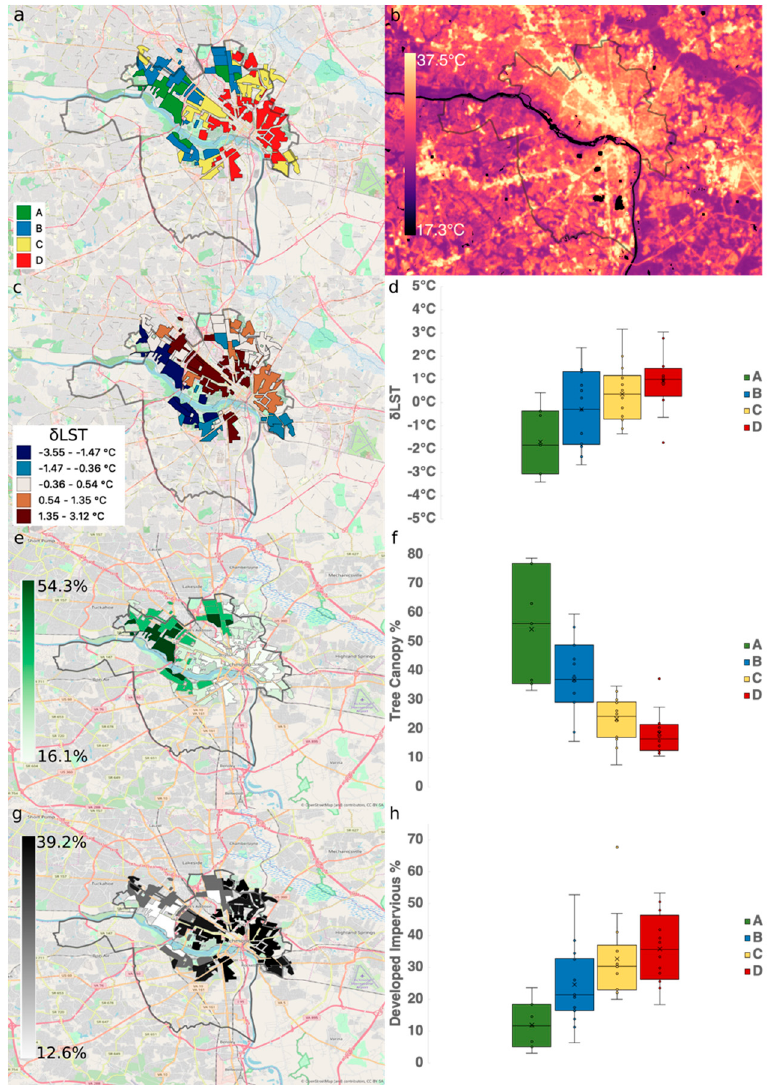
Figure 2. Demonstration of HOLC Security Grade δ LST and land cover analysis for Richmond, VA (grey outline). ( a ) HOLC Polygons for Richmond, VA [29] (see Introduction text for explanations of HOLC security grade color designations), ( b ) LST map for Richmond, VA derived from Landsat 8 TIRS Band 10 imagery collected on 2 July 2016, and ( c ) Resulting δ LSTs in HOLC polygons calculated as the anomaly of an individual HOLC polygon to the city-wide HOLC polygon average LST (see Equation (1)), ( d ) box–whisker plot of the δ LSTs presented in ( c ) binned by HOLC security rating (see Introduction text for explanations of designations), ( e ) percent tree canopy from NLCD 2011 [36] averaged into HOLC polygons, ( f ) box–whisker plot of the δ LSTs presented in ( e ) binned by HOLC security rating, ( g ) percent developed impervious surface from NLCD 2011 [36] averaged into HOLC polygons, ( h ) box–whisker plot of the average imperviousness presented in ( g ) binned by HOLC security rating.